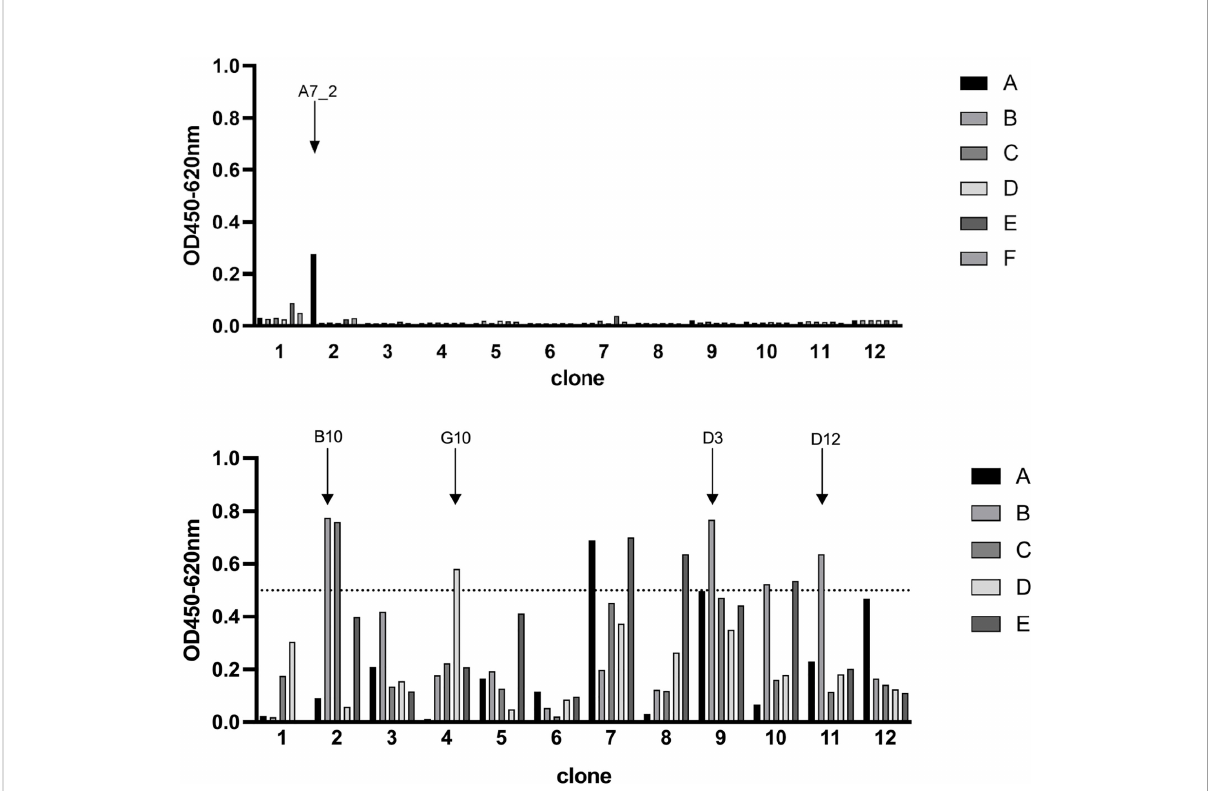
FIGURE 1 Phage display ELISA for the selection of SARS-CoV-2 Spike protein speci fi c VHHs. Wells were coated with antigen (SARS-CoV-2 Spike protein, 3 µg/mL) and blocked with 100 µL/well PBS/1% casein. Detection of speci fi c phages was performed with a HRP-conjugated M13 antibody (diluted 1:8000). Optical density was measured at 450 nm with a reference of 620 nm. Selected candidates are labeled with arrows. Blocking solution and a His-tagged irrelevant protein served as negative